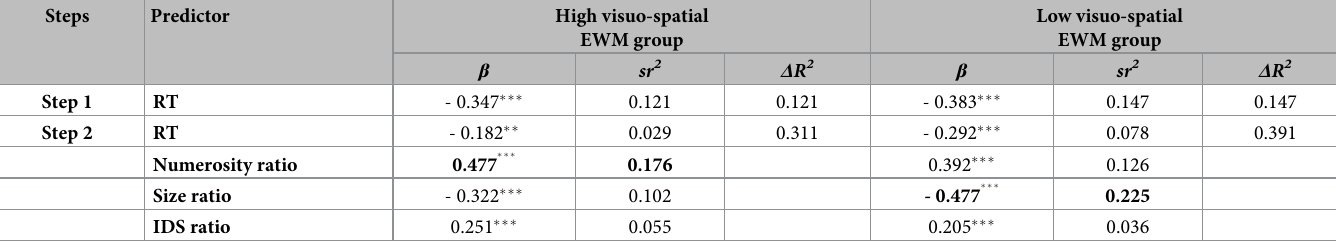
Table 3. Results of hierarchical regression on Numerosity Comparison accuracy of high vs. low visuo-spatial EWM